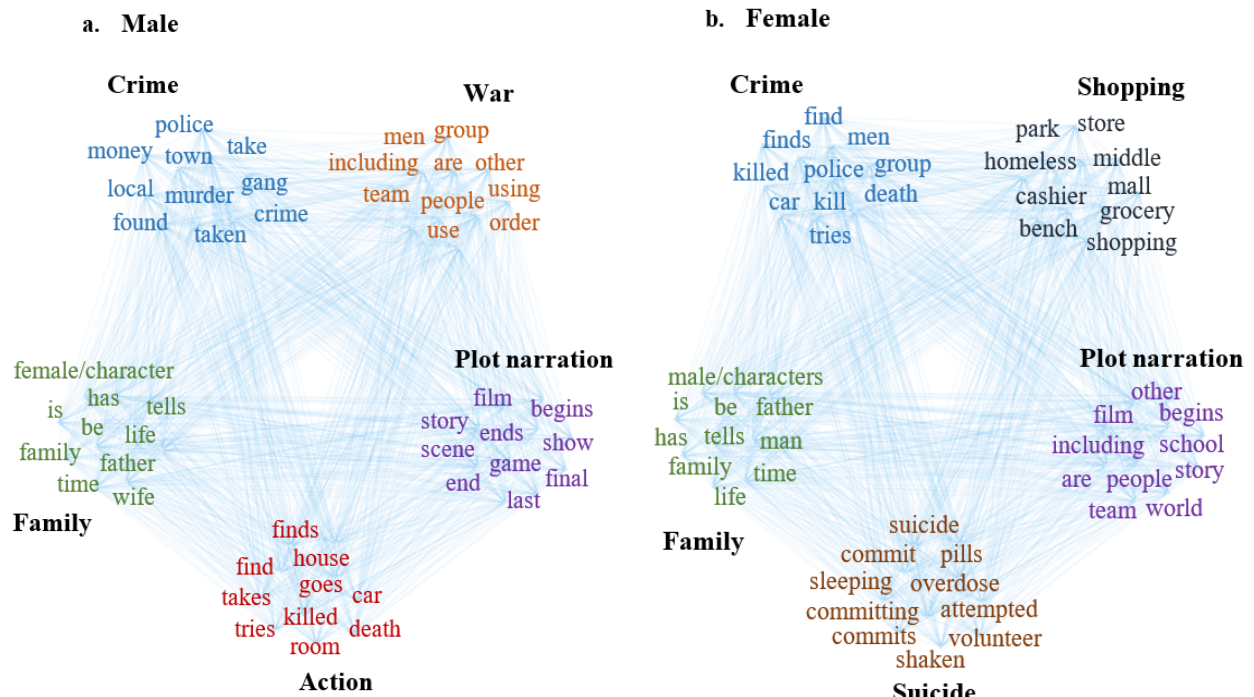
Figure 3. Communities identified in the co-occurrence networks. The male network ( a ) has 5355 vertices (words) and 1,979,829 edges (pairwise combinations of words within the data sample) and the female network ( b ) has 7393 vertices and 2,403,651 edges. We detected communities in the network using the Louvain algorithm. Five communities emerged in each of the networks, and the top ten vertices in terms of degree are shown.